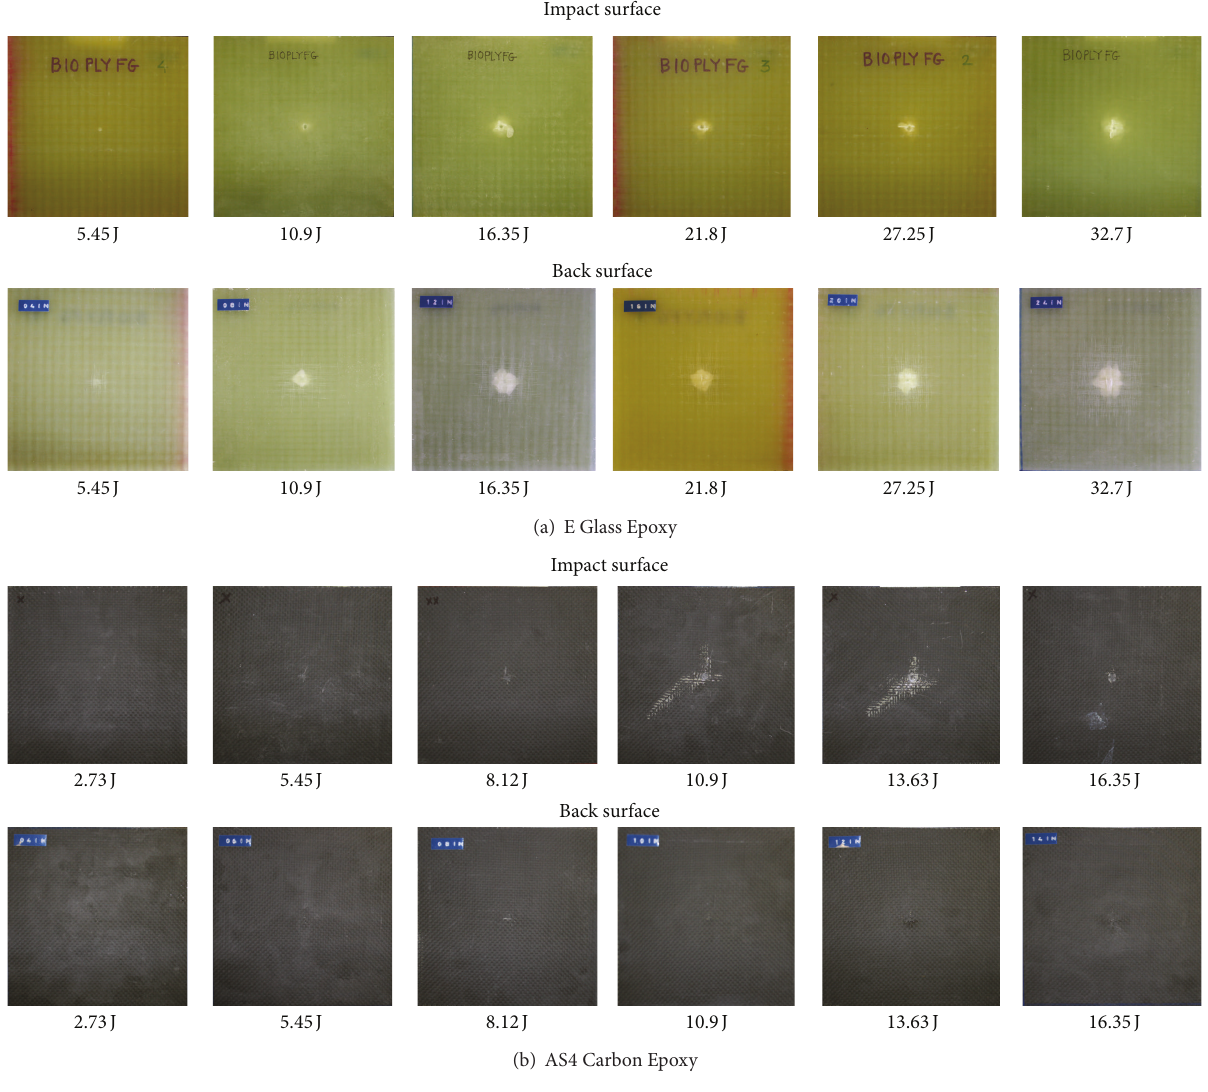
Figure 6: Progressive damage in E Glass AS4 Carbon laminates.